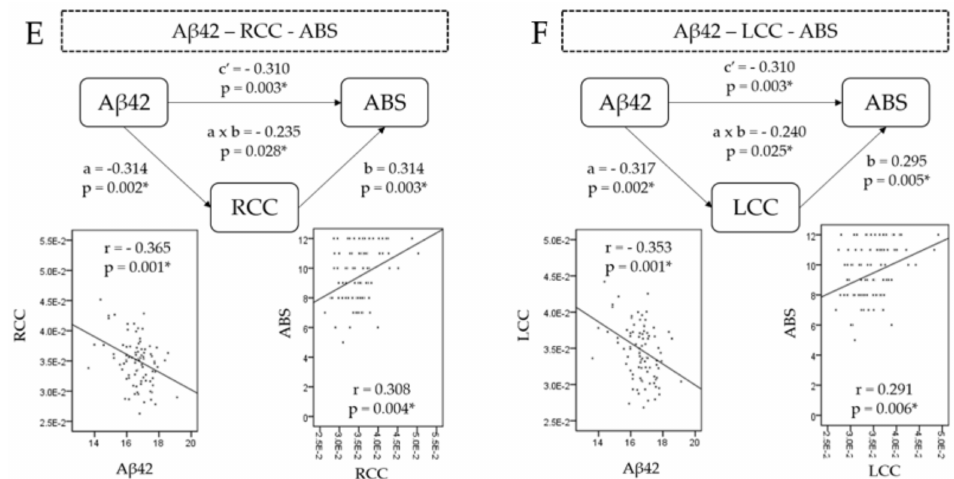
Figure 2. Mediation model. Mediation path diagram showing brain ROIs atrophy serve as a potential mediator between elevated plasma protein level and different cognitive functions. The correlation scatterplots indicate the relationship between misfolded protein level, brain atrophy, and cognitive functions. ( A ) revealed plasma p-Tau is negatively correlated with right accumbens area (r = − 0.321, p = 0.004), and right accumbens area is positively correlated with digit symbol coding (r = 0.318, p = 0.003). Right accumbens area completely mediated p-Tau—RAA—DSC relationship. ( B ) revealed plasma A β 42 is negatively correlated with right accumbens area (r = − 0.301, p = 0.006), and right accumbens area is positively correlated with digit symbol coding (r = 0.318, p = 0.003). Right accumbens area partially mediated A β 42—RAA—DSC relationship. ( C ) revealed plasma A β 42 is negatively correlated with left cerebellar cortex (r = − 0.353, p = 0.001), and left cerebellar cortex is positively correlated with digit symbol coding (r = 0.320, p = 0.002). Left cerebellar cortex partially mediated A β 42—LCC—DSC relationship. ( D ) revealed plasma A β 42 is negatively correlated with right accumbens area (r = − 0.301, p = 0.006), and right accumbens area is positively correlated with abstract thinking (r = 0.296, p = 0.005). Right accumbens area partially mediated A β 42—RAA—ABS relationship. ( E ) revealed plasma A β 42 is negatively correlated with right cerebellar cortex (r = − 0.365, p = 0.001), and right cerebellar cortex is positively correlated with abstract thinking (r = 0.308, p = 0.004). Right cerebellar cortex partially mediated A β 42—RCC—ABS relationship. ( F ) revealed plasma A β 42 is negatively correlated with left cerebellar cortex (r = − 0.353, p = 0.001), and left cerebellar cortex is positively correlated with abstract thinking (r = 0.291, p = 0.006). Left cerebellar cortex partially mediated A β 42—LCC—ABS relationship. * Indicates p < 0.05. Abbreviations: p-Tau (phosphorylated-Tau), RAA (right accumbens area), DSC (digit symbol coding), A β 42 Beta-amyloid-42), LCC (left cerebellar cortex), ABS (abstract thinking), RCC (right cerebellar cortex), a (Coef a ), b (Coef b ), a × b (Coef ab ), c (cid:48) (Coef c (cid:48)